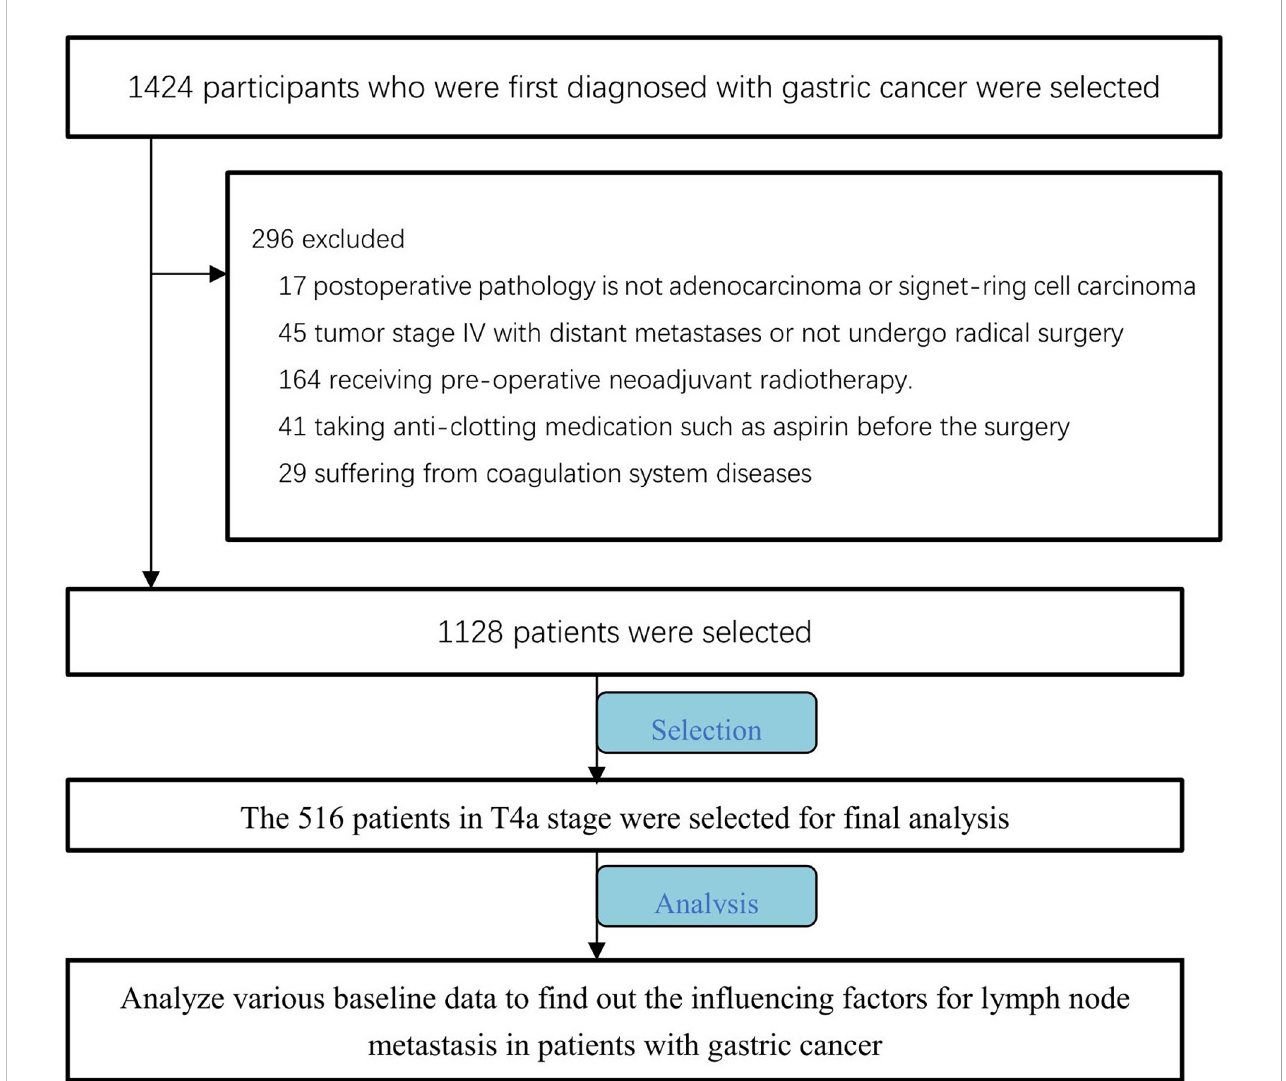
FIGURE 1 Patient selection fl ow